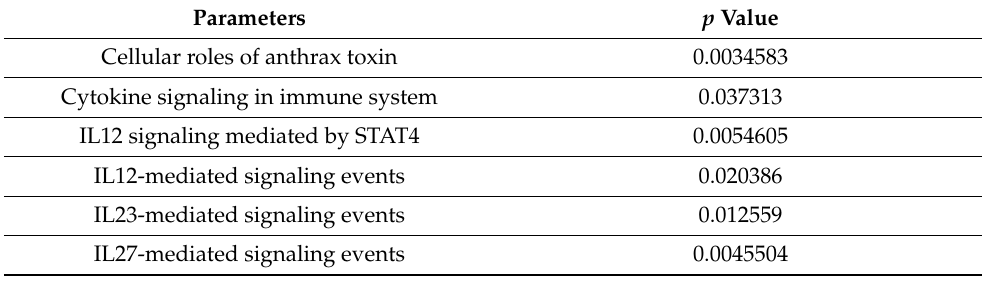
Table 2. Prediction of host pathogens interaction by PHIST.